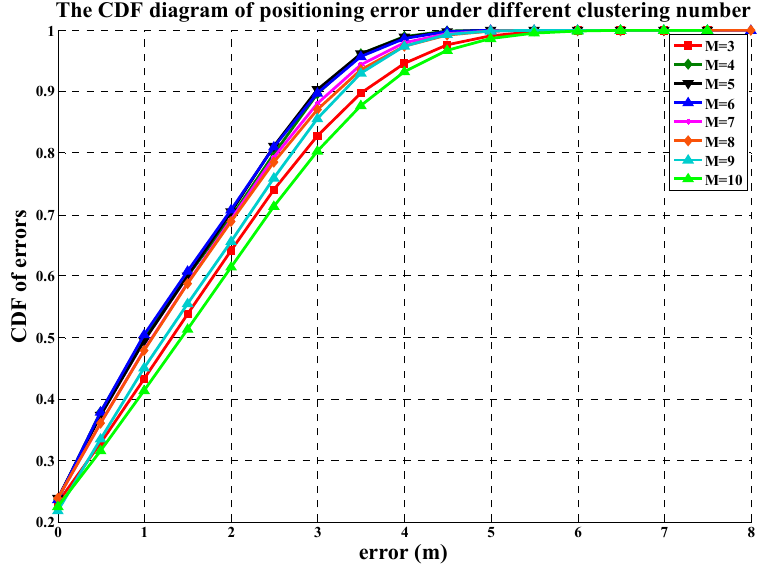
Figure 15. The CDF diagram of positioning error under different clustering numbers.